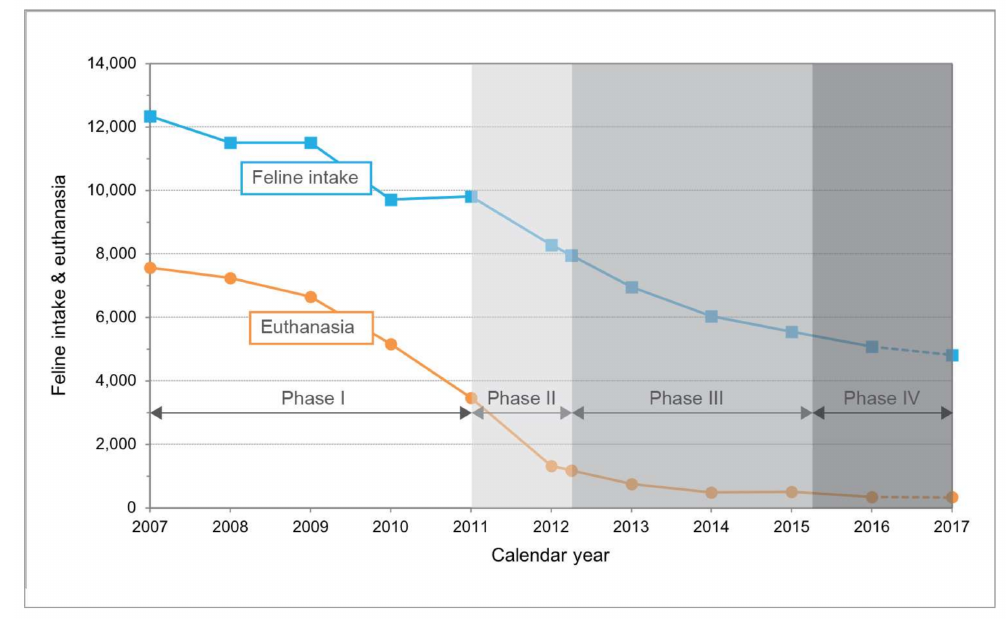
Figure 2. Annual feline intake and euthanasia at Albuquerque Animal Welfare Department,